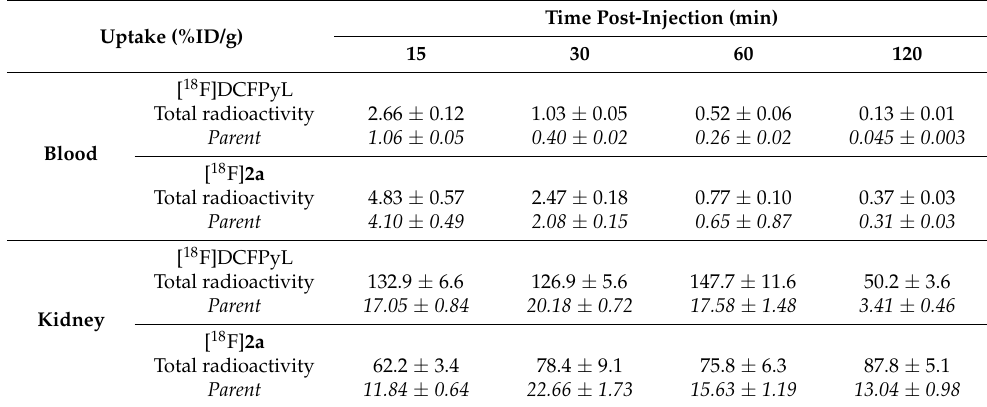
Table 3. Comparison of [ 18 F]DCFPyL and [ 18 F] 2a total radioactive uptake (%ID/g) and parent (corrected for metabolites) uptake (%ID/g) in the blood and kidneys after 15, 30, 60 and 120 min. Each value represents the mean (%ID/g) ± SE [ n = 8–10 ([ 18 F]DCFPyL); n = 5–6 per group ([ 18 F] 2a )]. Time Post-Injection (min) Uptake (%ID/g) 15 30 60 120 [ 18 F]DCFPyL Total radioactivity 2.66 ± Blood